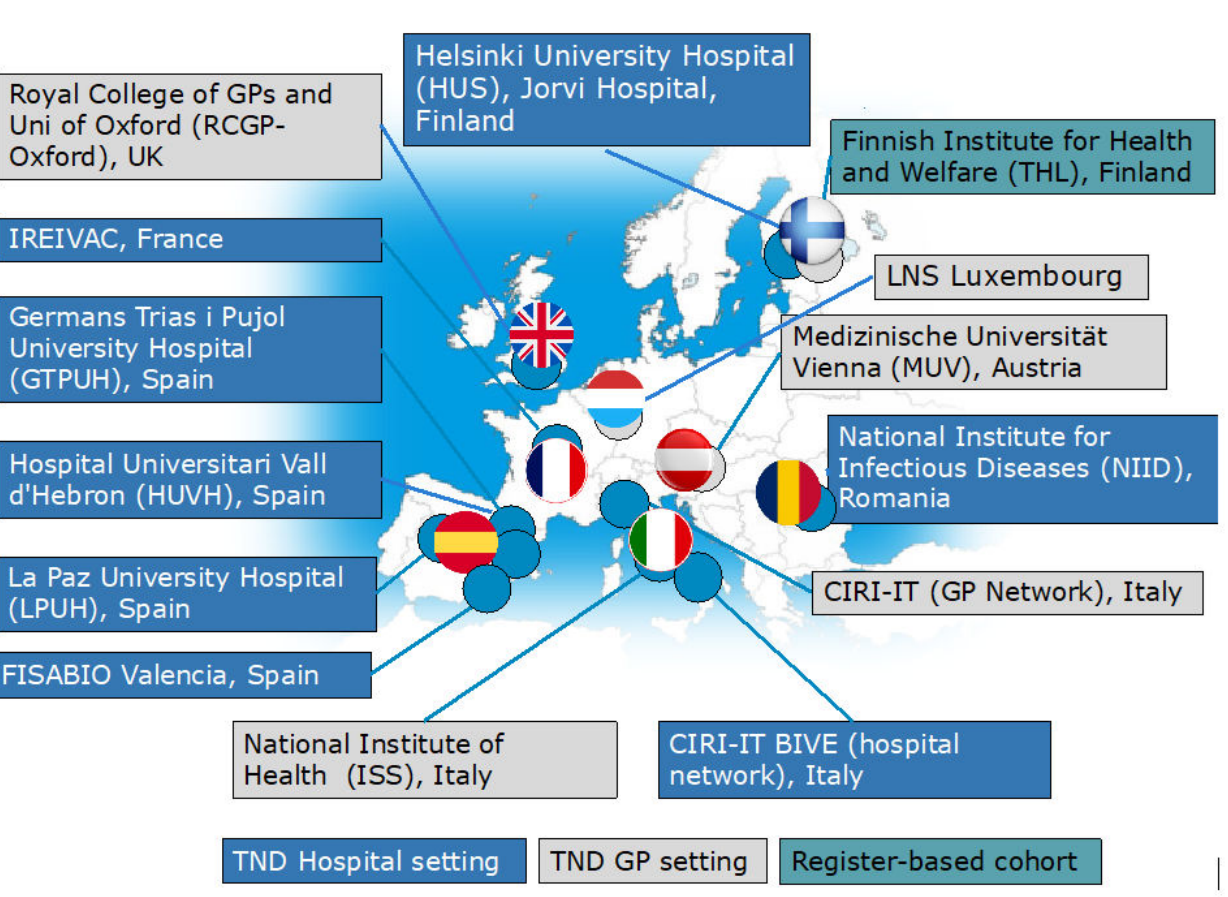
Figure 1. DRIVE study sites 2019/2020 map. Fourteen study sites from a total of eight different European countries collected data for DRIVE during the 2019/2020 influenza season. In total, there were 19 hospitals and 388 GPs for the TND studies and more than 1.5 million subjects for the register-based cohort